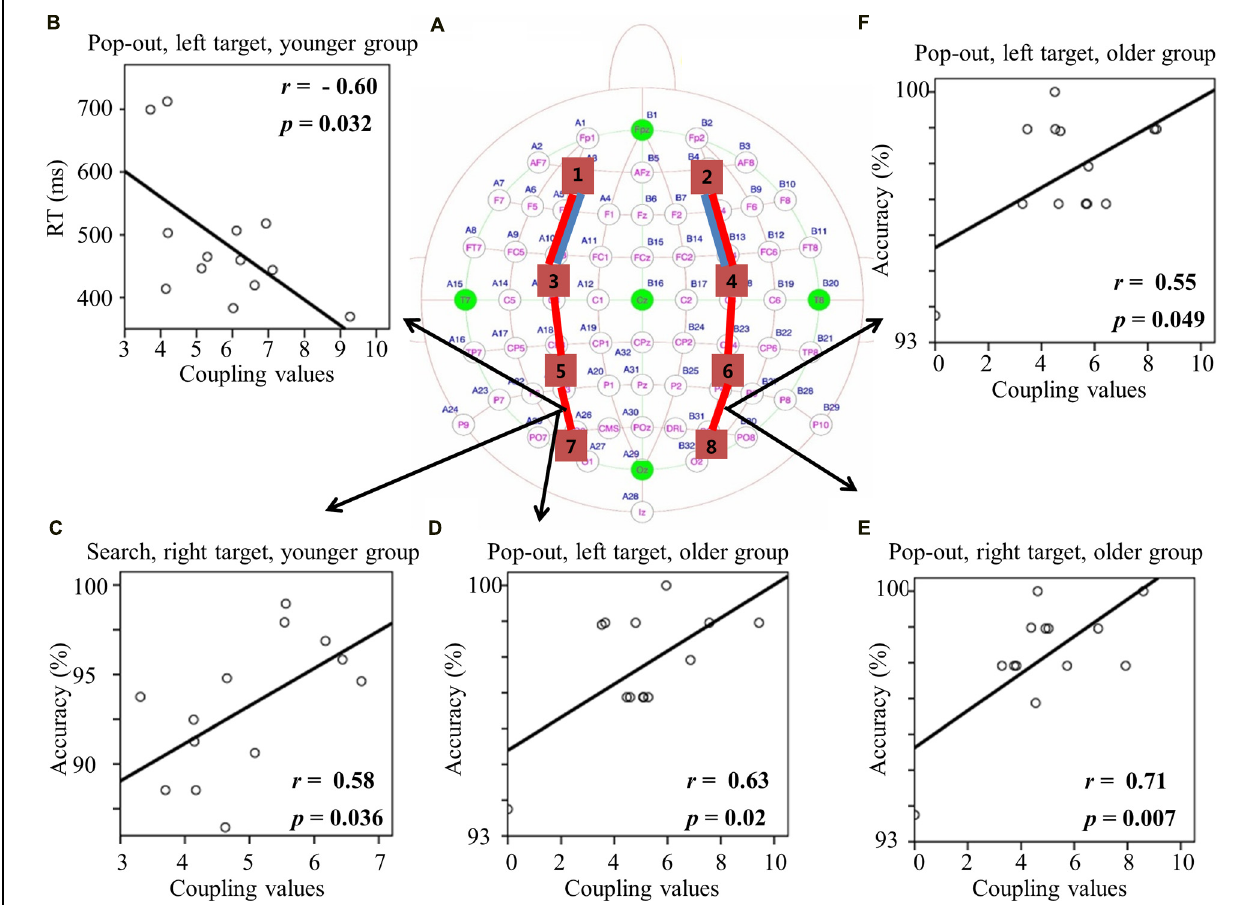
FIGURE 6 | (A) Inter-regions coupling in beta frequency band. Blue lines indicate main effect of age (younger > older) and red line indicates main effect of condition (pop-out > search). (B) Linear negative regression between mean RT and coupling value between left central-parietal and parietal-occipital regions for the pop-out condition with the left field target in the younger group. Linear positive regression between mean accuracy and coupling value between left central-parietal and parietal-occipital regions for the search condition with the right target in the younger group (C) and for the pop-out condition with the left target in the older group (D) . Linear positive regression between mean accuracy and coupling value between right central-parietal and parietal-occipital regions for the pop-out condition with the right target (E) and the left target (F) in the older group.